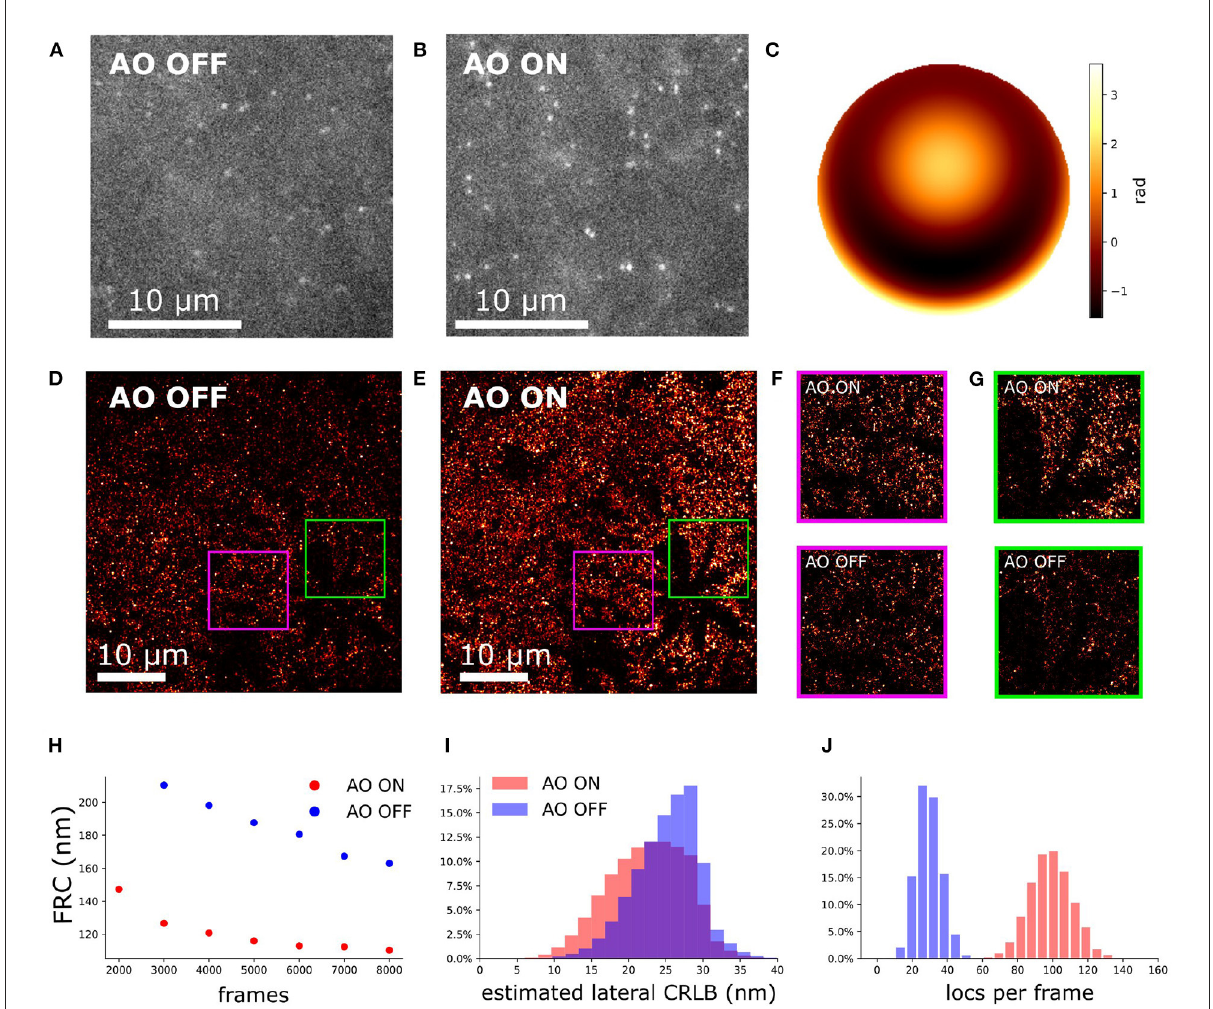
FIGURE10 Aberration correction on an artificial thick sample with Caco2-BBE cells labeled against Ezrin. (A) Raw camera image of Caco2-BBE STORM sample without aberration correction. (B) Raw camera image of Caco2-BBE STORM data with aberration correction. (C) The pupil phase for aberration correction. (D) Reconstruction image of Caco2-BBE sample without aberration correction. (E) Reconstruction image of Caco2-BBE sample with aberration correction. (D,E) Rendered with the same contrast to visualize the localization density. (F) Zoom-in of (D,E) . (G,H) FRC of (D,E) verse the frame number. (I) Lateral CRLB distribution from the data-set of (D,E) . (J) Number of detected localizations per frame from the dataset of (D,E)